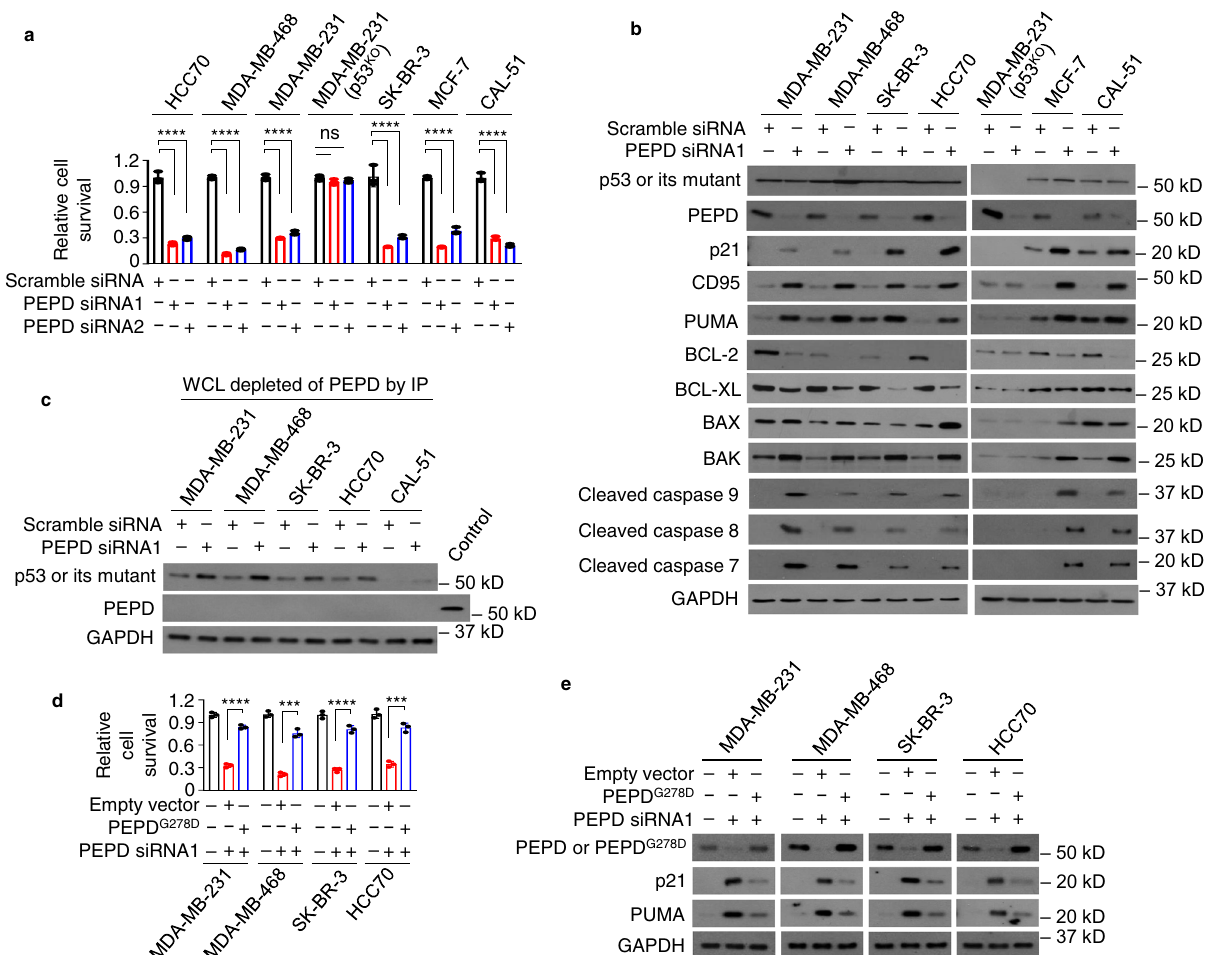
Fig. 3 PEPD KD reactivates p53 mutants in cells by disrupting their binding to PEPD. a Cells were treated by siRNA (10 nM) for 72 h. Cell viability were measured by trypan blue assay. b Cells were treated by siRNA (10 nM) for 48 h. p53 and other proteins in WCL were analyzed by WB. c Cells were treated by siRNA (10 nM) for 48 h. PEPD, PEPD-p53 complexes, and PEPD-p53 mutant complexes in WCL were pulled down by PEPD IP, and the supernatant was analyzed for p53, p53 mutants and PEPD by WB. WCL of untreated MDA-MB-231 cells was used as a PEPD control in WB. d , e Cells were transfected with or without PEPD G278D , and 24 h later treated by vehicle or PEPD siRNA (10 nM) for 72 h. Cell viability was measured by trypan blue assay in d . PEPD and other proteins in WCL were analyzed by WB in e . Cells carrying p53 (MCF-7 cells and CAL-51 cells) or MDA-MB-231 (p53 KO ) cells were included in a – c for comparison. GAPDH is a loading control in b , c , and e . The bar-dot plots in a and d show individual values and mean ± SD ( n = 3). *** P < 0.001, **** P < 0.0001, ns — not signi fi cant, by analysis of variance followed by Tukey test in a or by paired two-tailed t -test in d